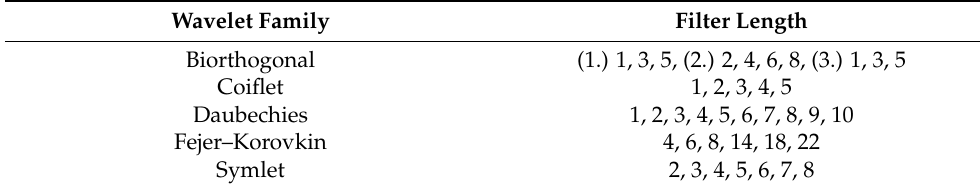
Table 2. Wavelet families and filter lengths used in the